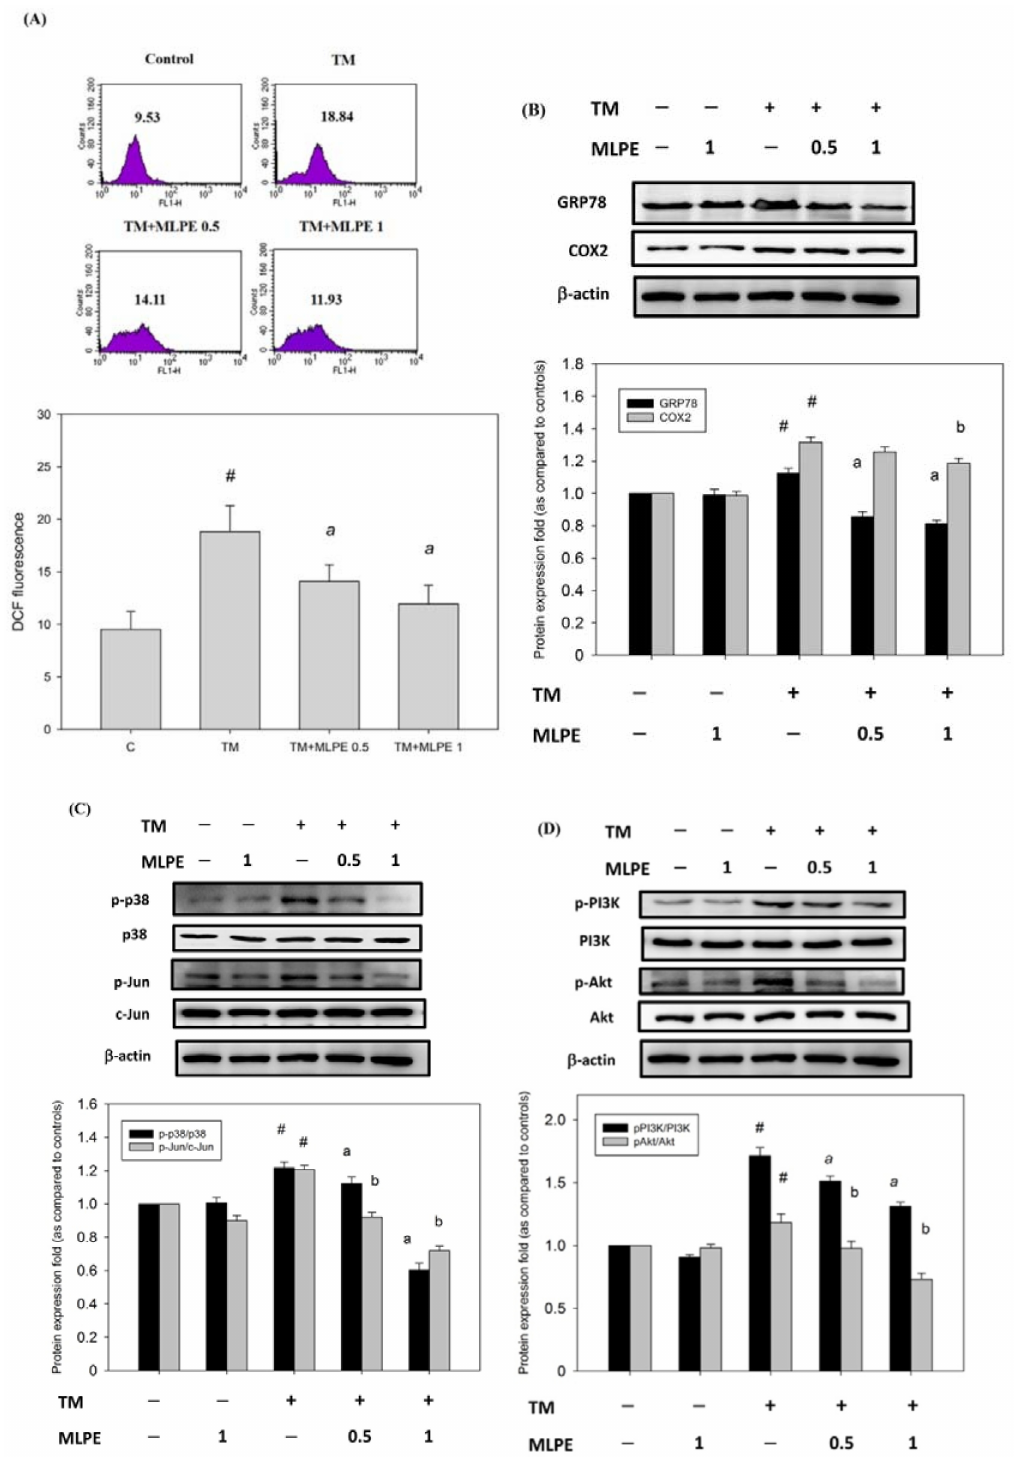
Figure 4. MLPE reduced the level of reactive oxygen species (ROS) and the expression of COX-2, GRP78, p38 / Jun, and PI3K / Akt in tunicamycin-induced HepG2 cells. HepG2 cells were treated with TM in the absence (control) or the indicated concentration of MLPE (0.5 and 1 mg / mL) for 8 h. ( A ) Intracellular ROS was detected by dichloro-dihydro-fluorescein diacetate (DCFH-DA) fluorescence. Data were analyzed with flow cytometry. Quantitative assessment was carried out of the DCF fluorescence